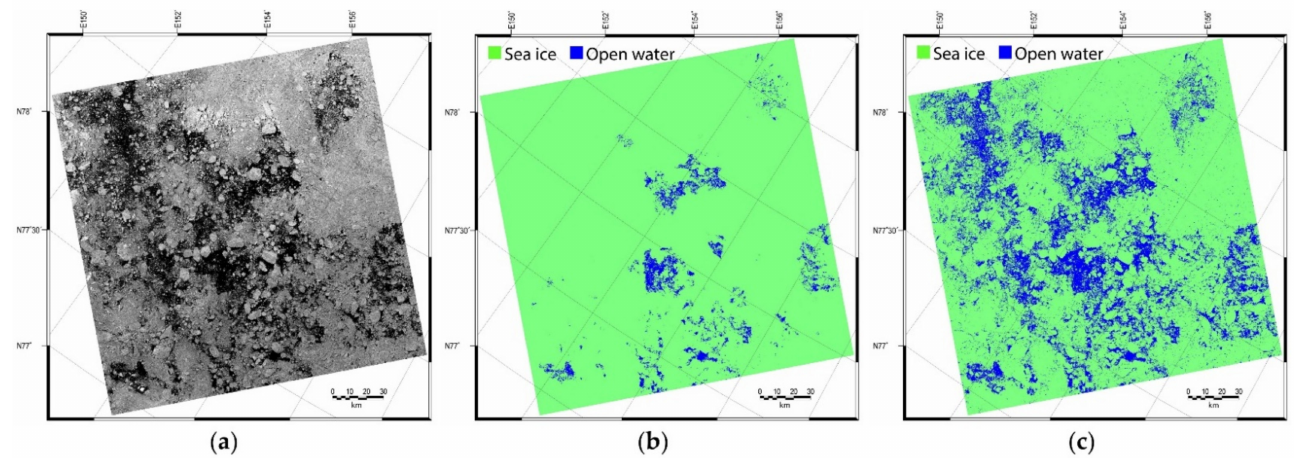
Figure 3. An example of ( a ) a Landsat-8 OLI panchromatic image resampled to a grid of 100 m and corresponding ice/water classification map, in which the open water was classified from albedo values of less than ( b ) 0.1 and ( c )